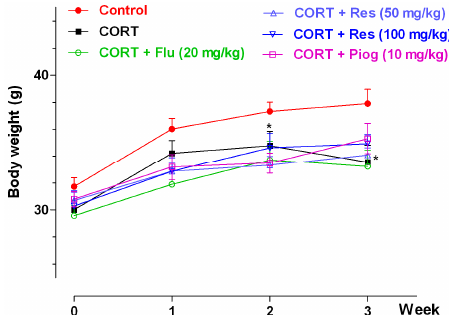
Figure 2. Effects of resveratrol on the body weight in mice. Data were expressed as the mean ± S.E.M. ( n = 10). * p < 0.05 vs . control group. Data was analyzed by two-way repeated-ANOVA with week as the repeat factor. The difference between groups at the same time point was analyzed by Dunnett ′ s post hoc test. CORT: corticosterone; Flu: fluoxetine; Res: resveratrol; Piog: pioglitazone.